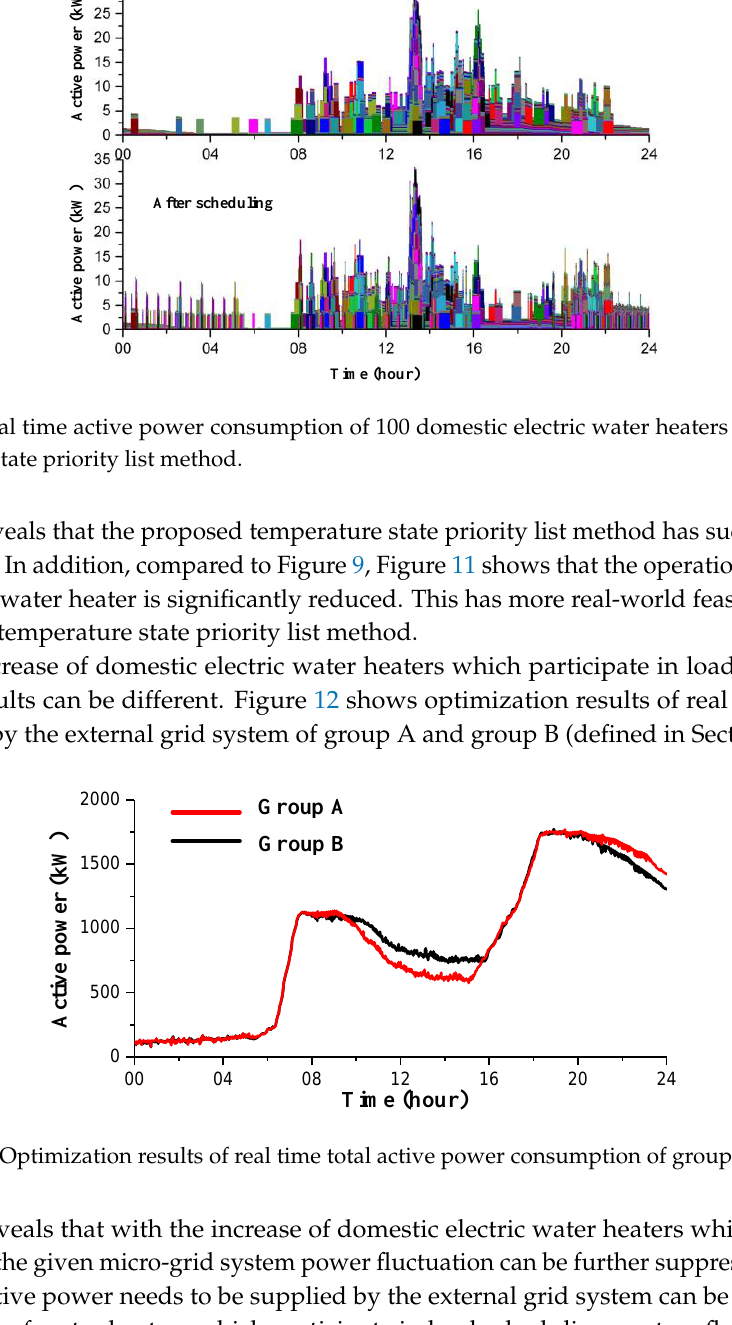
Figure 10. Optimization results of the simplified temperature state priority list and the temperature state priority list control strategies.